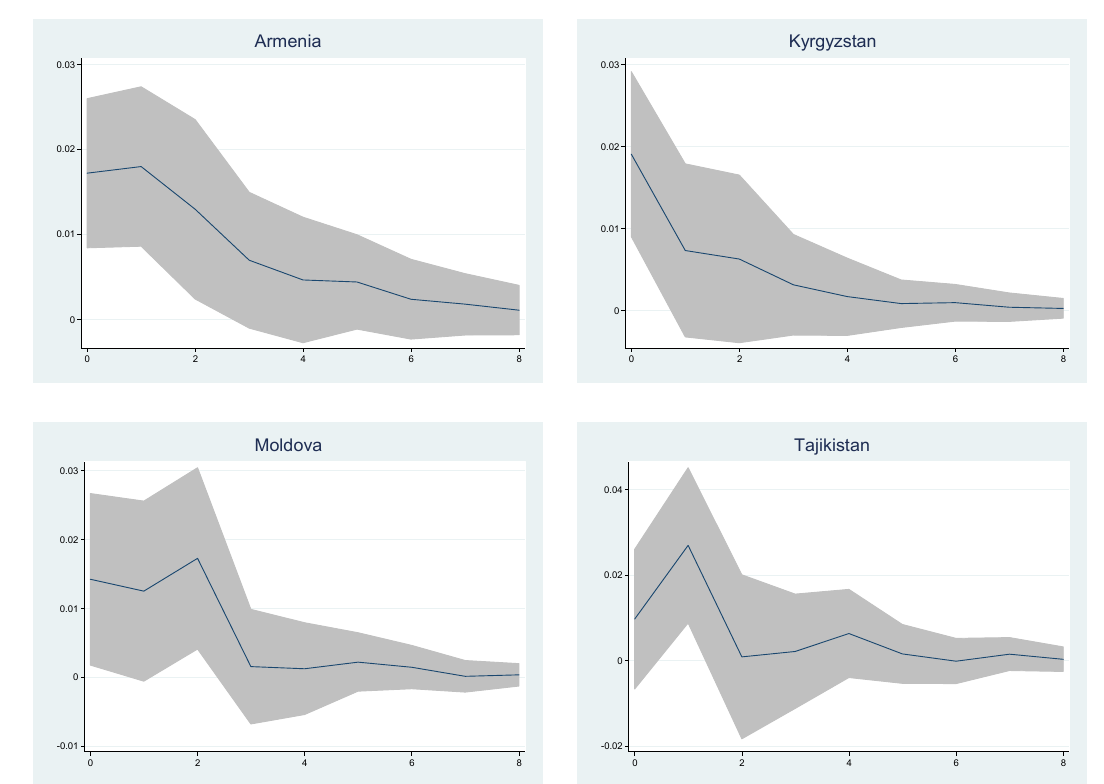
Figure 1. Impulse Response Functions (IRFs) of the VAR Model, Small Economies. Note: Response of the GDPs of CIS countries to the Russian GDP. Table 9 presents the VAR model estimation results for the logarithmic difference of the GDPs of Russia and two large economies (Belarus and Ukraine) without significant fuel resources. The number of lags selected by the AIC criterion was one. The estimation results show a statistically significant positive impact of one-period-lagged Russian GDP on the current-period GDP of Ukraine. The impact is statistically significant at the 1% sig- nificance level. The Lagrange-multiplier test results indicate no serial correlation in the residuals. Johansen’s test for cointegration does not reject the null hypothesis of no coin- tegration between the variables. Table 9. VAR Model Estimation Results for Logarithmic Difference of GDP, Large Economies with- out Significant Fuel Resources. Independent Variables